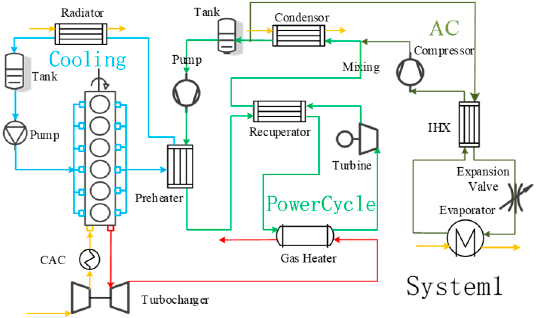
Figure 8. Co-cooling single compression system.